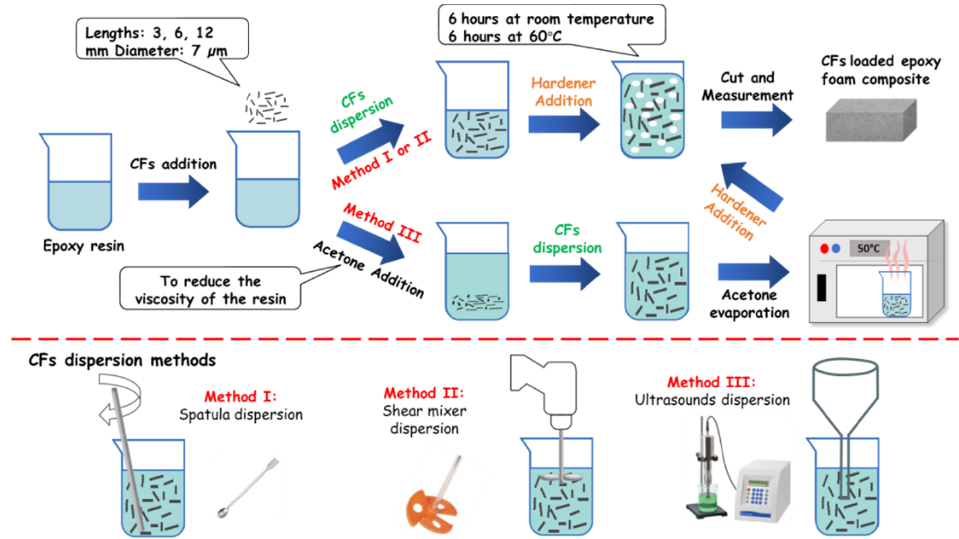
Figure 1. Schematic diagram of the elaboration method of the carbon fibers (CFs)-loaded epoxy foam composites and the used CFs dispersion methods.